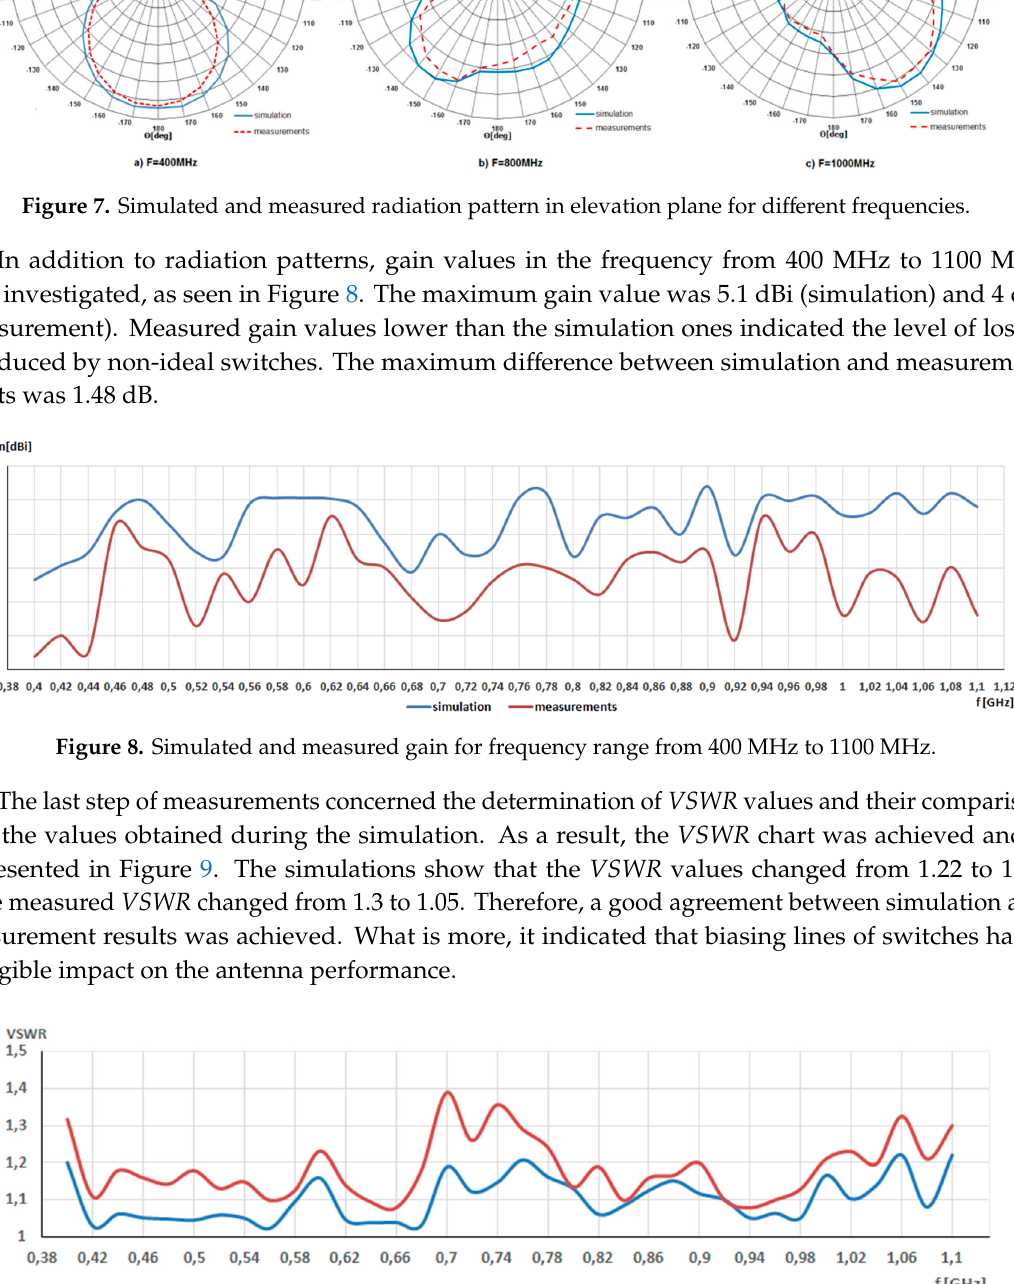
Figure 7. Simulated and measured radiation pattern in elevation plane for different frequencies.